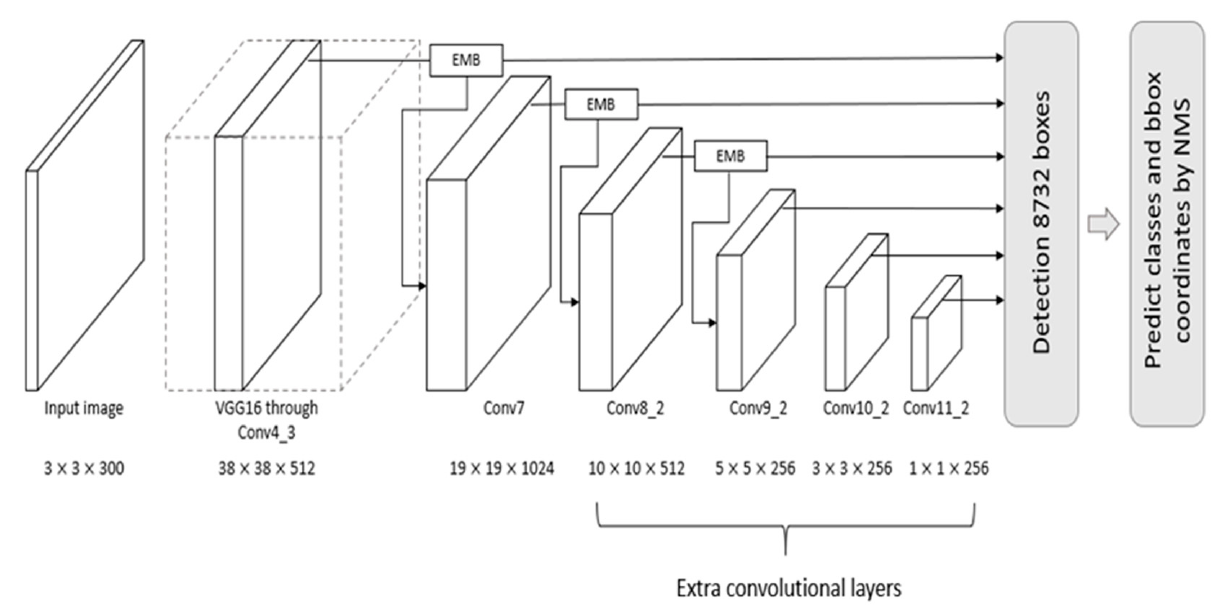
Figure 1. Overall architecture of the single-shot multibox detector with the enhanced map block (SSD-EMB). The input of the EMB is a feature map produced from convolutional layers. The EMB is applied after the Conv4_3, Conv7, and Conv8_2 layers. The output of the EMB is used as an input of the next convolutional layer. Please note that this figure presents the case in which the detector is the SSD300. If the SSD512 detector is used, an additional EMB is applied after Conv9_2. Similar to the original SSD, the 8732 bounding boxes include 5776 (38 × 38 × 4) boxes from Conv4_3, 2166 (19 × 19 × 6) boxes from Conv7, 600 (10 × 10 × 6) boxes from Conv8_2, 150 (5 × 5 × 6) boxes from Conv9_2, 36 (3 × 3 × 4) boxes from Conv10_2, and 4 (1 × 1 × 4) boxes from Conv11_2.